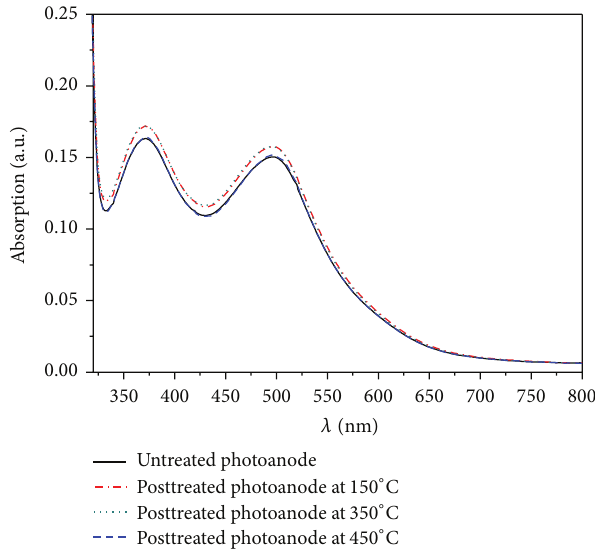
Figure 3: Absorbance of aqueous solution of N3 dye desorbed from TiO 2 mesoporousfilms;untreatedphotoanode(blacksolidline)and the posttreated photoanodes at 150 ∘ C (red dot-dash line), 350 ∘ C (green dotted line), and 450 ∘ C (blue dashed